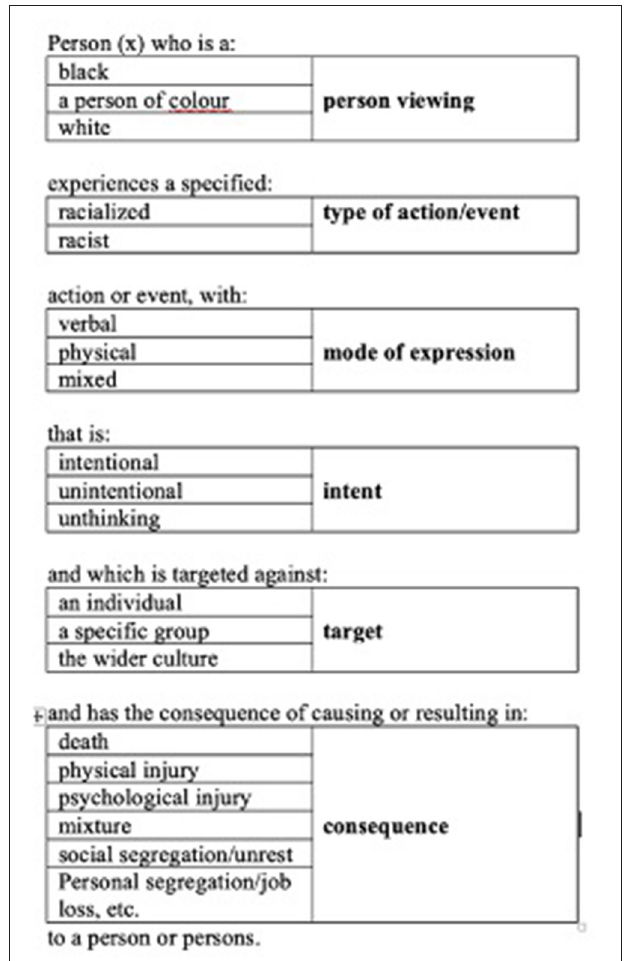
FIGURE 1 | Declarative mapping sentence for understanding acts of racism (adapted from Hackett and Schwarzenbach,